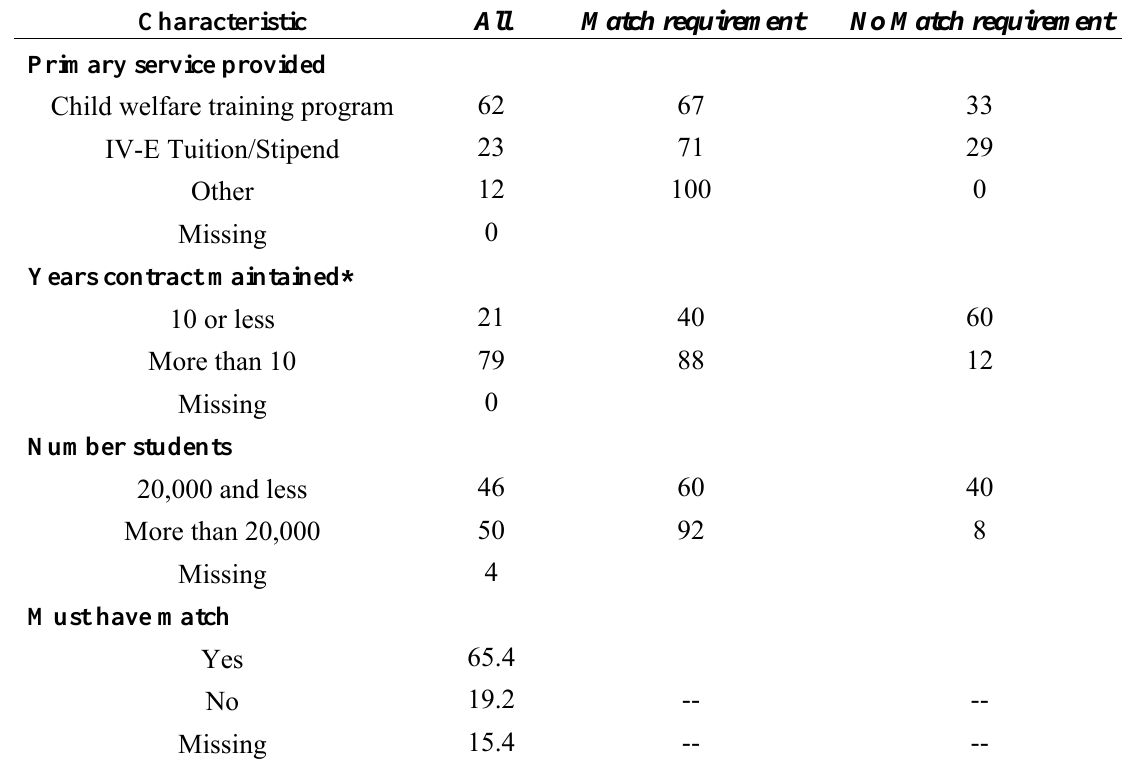
Table 3. Characteristics of Child Welfare Partnerships and Prevalence (%) of Matching Dollar Requirements (N =